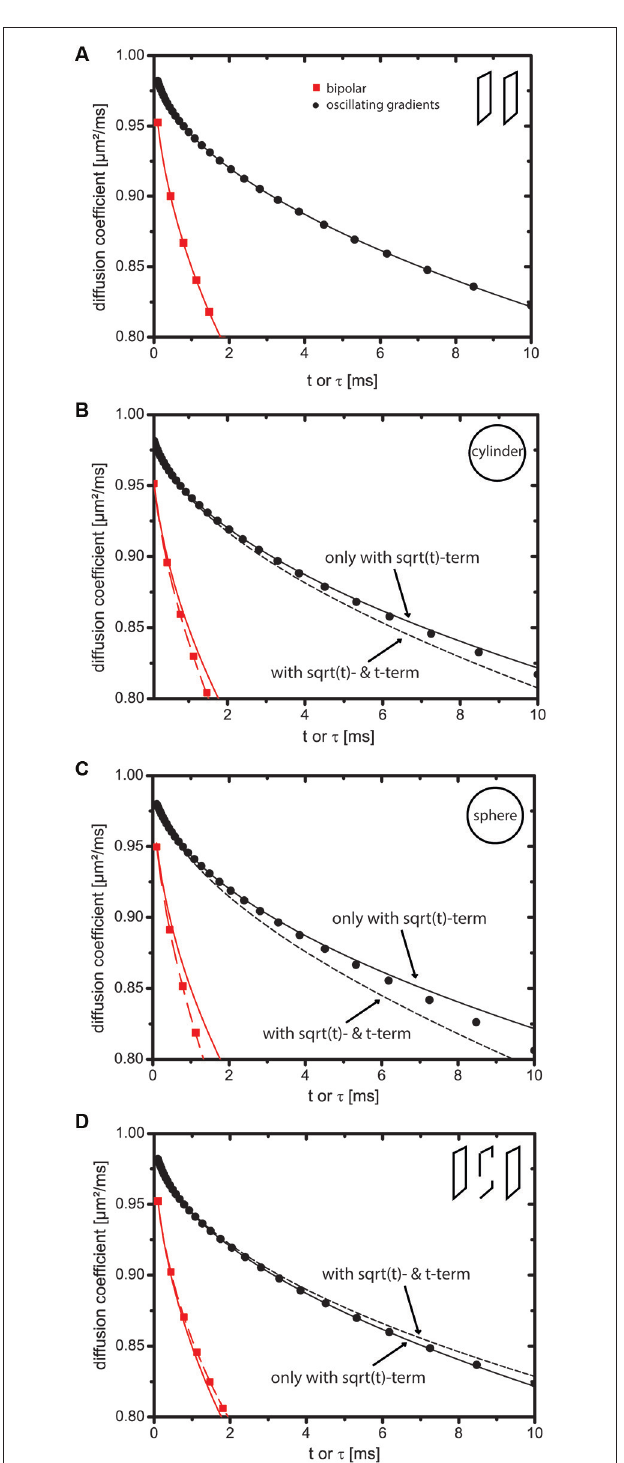
FIGURE 1 | Impact of the t -term on the short-time expansion of the diffusion coefficient. Markers indicate values obtained by numerical simulations. Solid lines represent the short-time expansion to order √ t and dotted lines represent it to order t . Red square markers represent bipolar gradients (i.e., D app ( t ) ) andblackcircularmarkersrepresentoscillatingcosinegradients(i.e., D app (τ) ).